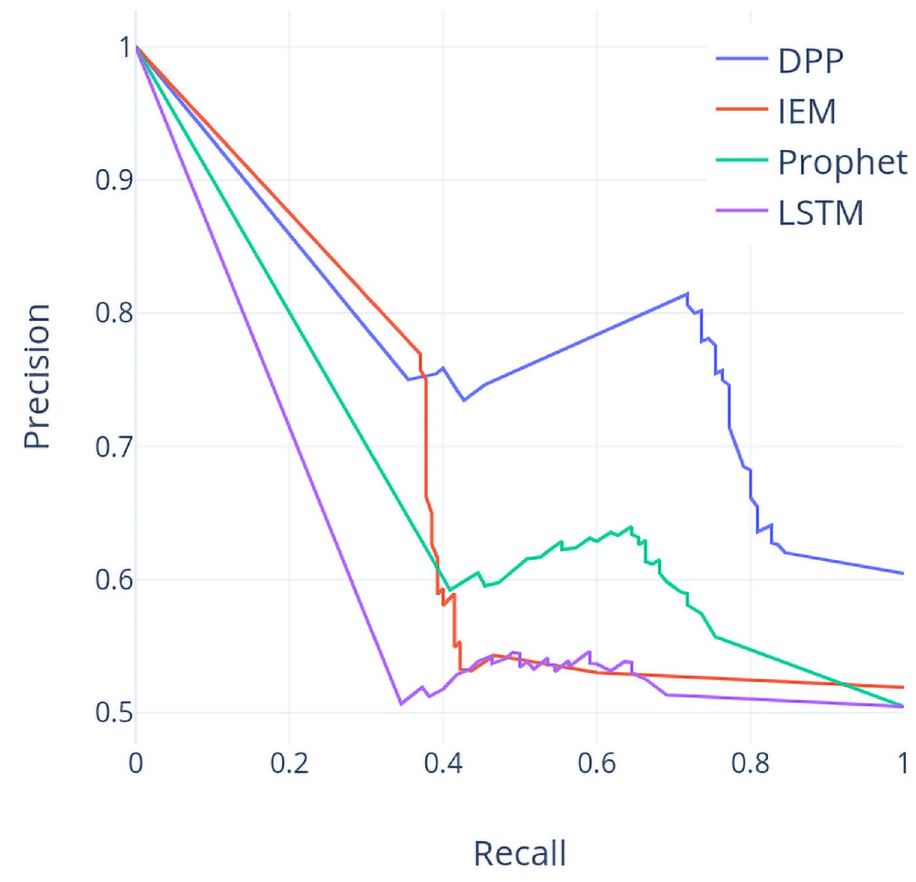
Fig 12. PR curve (NI225 dataset).